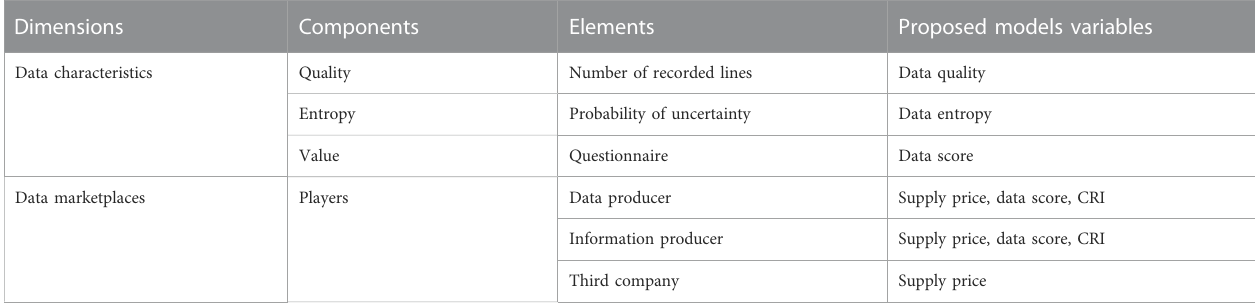
TABLE 5 Research framework.